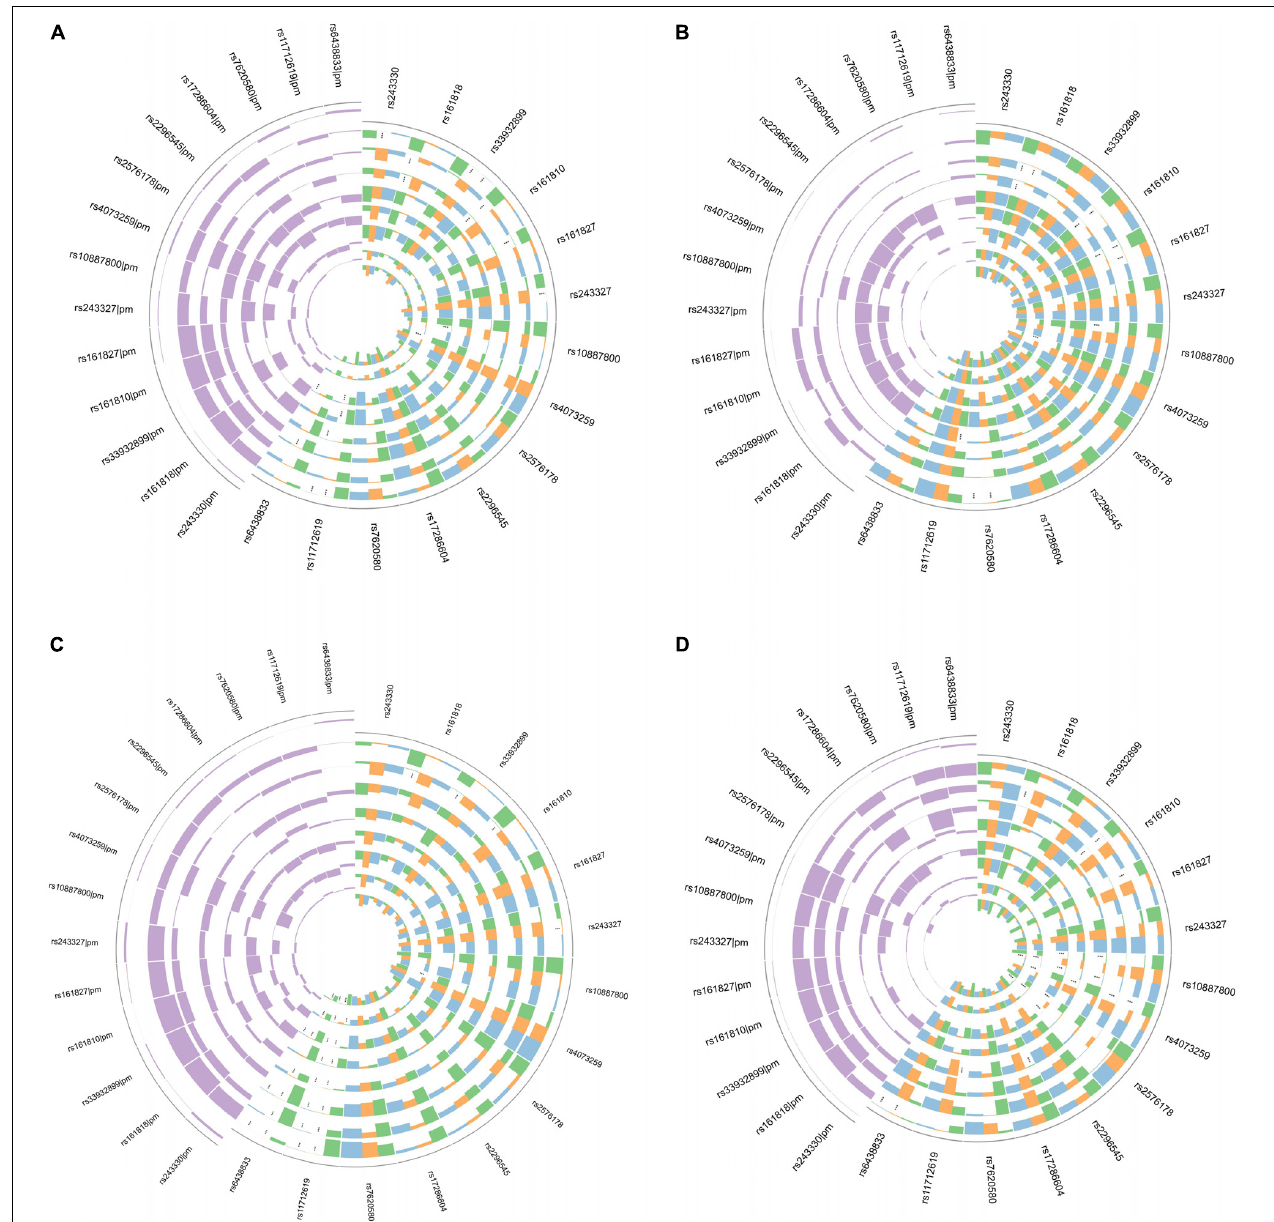
FIGURE 1 | Circos plot showing the mediation model of the SNP, risk factors and IS (A) ; SNP, risk factors and atherothrombosis subtype of IS (B) ; SNP, risk factors and lacunar subtype of IS (C) ; SNP, risk factors and combination subtype of IS (D) . Purple in the upper left corner showing Prop Mediated (pm). The outer layer to the inner of ring were BMI, systolic BP, diastolic BP, blood glucose, TC, TG, HDL, LDL, respectively. Green indicate mediated effect p -value; orange indicate direct effect p -value; blue indicate total p -value. *** p < 0.05.